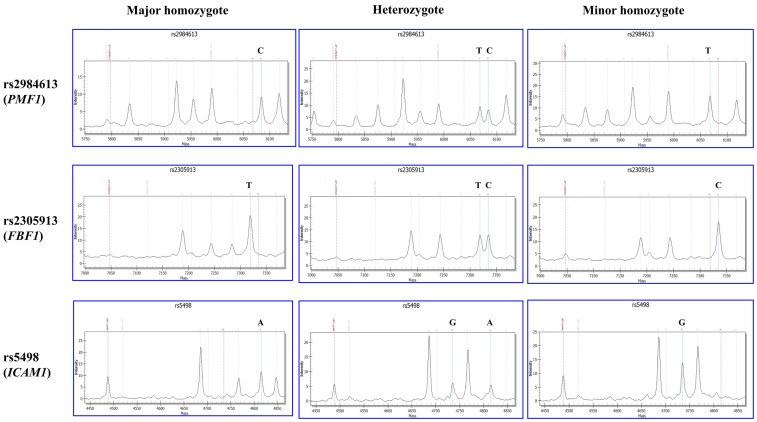
Matrix-assisted laser desorption/ionization time-of-flight mass spectrometry (MALDI-TOF MS)-based genotyping of rs2984613 in PMF1, rs2305913 in FBF1, and rs5498 in ICAM1. The X and Y axes represent the mass and intensity of extension product, respectively. The red dotted line on the left indicates the mass of extension primer. The bean green dotted line on the right indicates the extension product on the major or minor allele. The left and right columns show the MS result of major homozygote (wild type) and minor homozygote (mutant), respectively. The middle column shows the MS result of heterozygote.